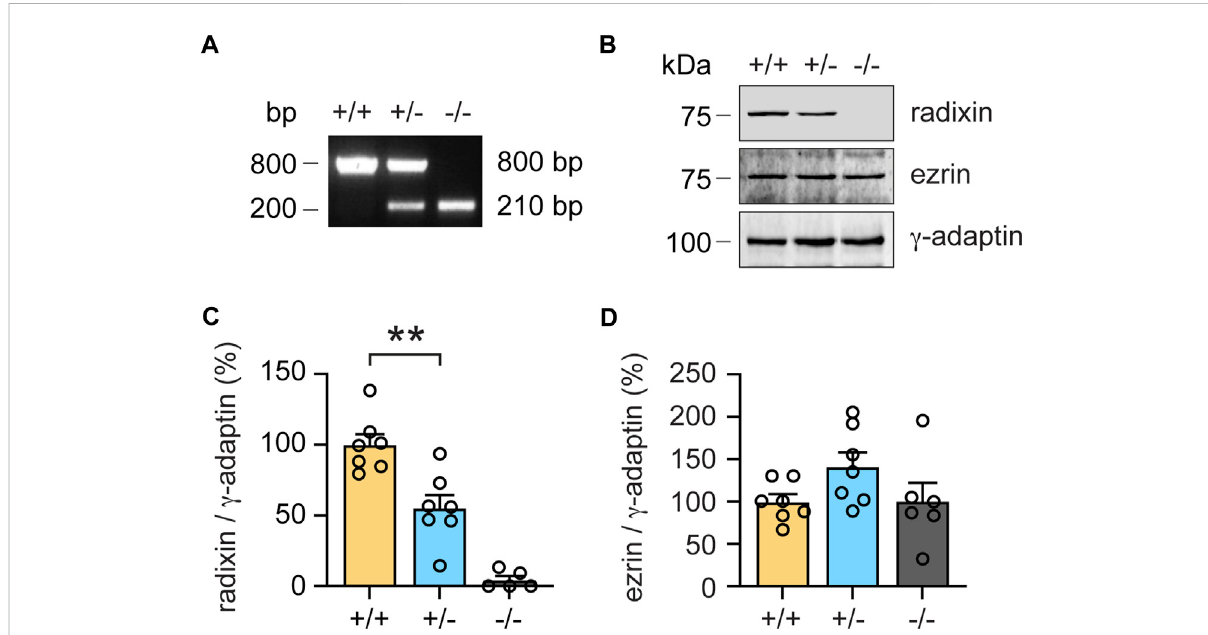
FIGURE 3 Monoallelic loss of rdx reduces radixin protein expression in the cochlea. (A) Representative genotyping PCR of wildtype (+/+), heterozygous (+/-) and homozygous ( − / − ) rdx knockout mice. Base pairs (bp). (B) Representative western blot analysis of radixin (Rdx) and ezrin (Ezr) in cochlea extractsderivedfrom(+/+),(+/-)and( − / − ) rdx knockoutmice. γ -adaptinwasusedasloadingcontrol.Kilodalton(kDa). (C,D) Quanti fi cationofRdx (C) and Ezr (D) signal intensities normalized to γ -adaptin as shown in (B) . (+/+) set to 100%. N = 7-5 mice per genotype. Independent